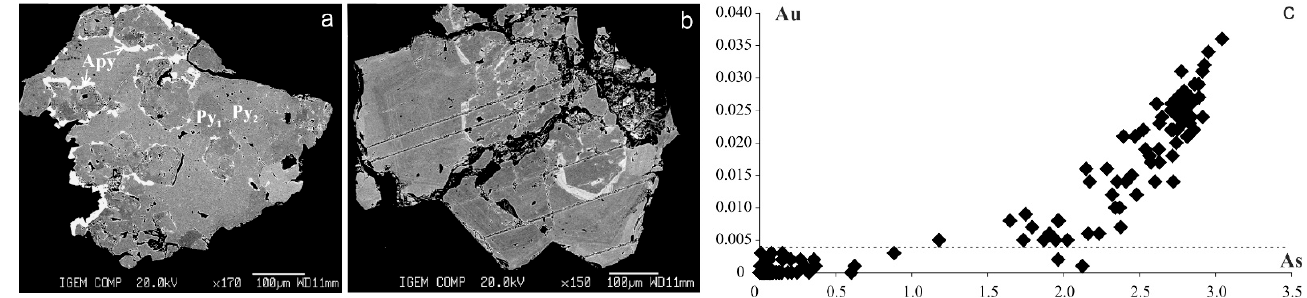
Figure 9. Pyrite from the gold-skarn ore of the Vorontsovka deposit. ( a ) A crystalline granular aggregate of pyrite of different generations (Py1 and Py2), and arsenopyrite crystallises in the intergranular space of these pyrite generations. ( a, b ) BSE images, Jeol JXA-8200. ( b ) An aggregate of zonal pyrite crystals: in bright zones, the As content is about 4 wt%. ( c ) Distribution of As and Au contents (EPMA, wt%) in pyrite; the dashed line is Au detection limit.